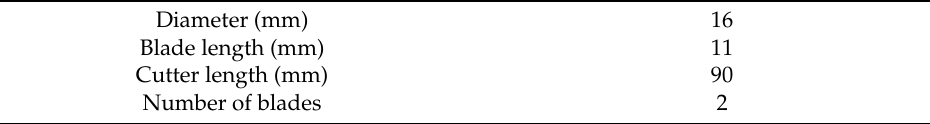
Table 1. Specifications of